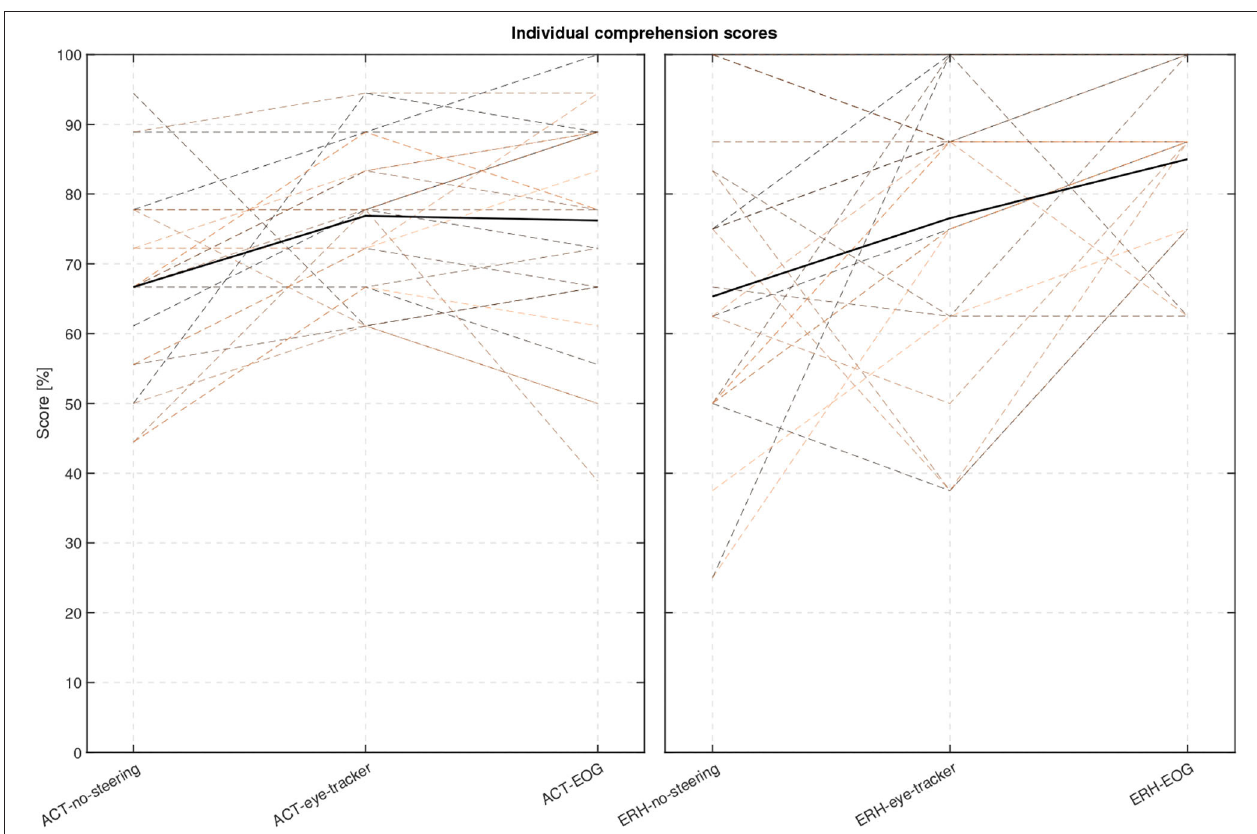
FIGURE 12 | Individual comprehension performance scores for each participant and conditions with the mean scores shown as thick